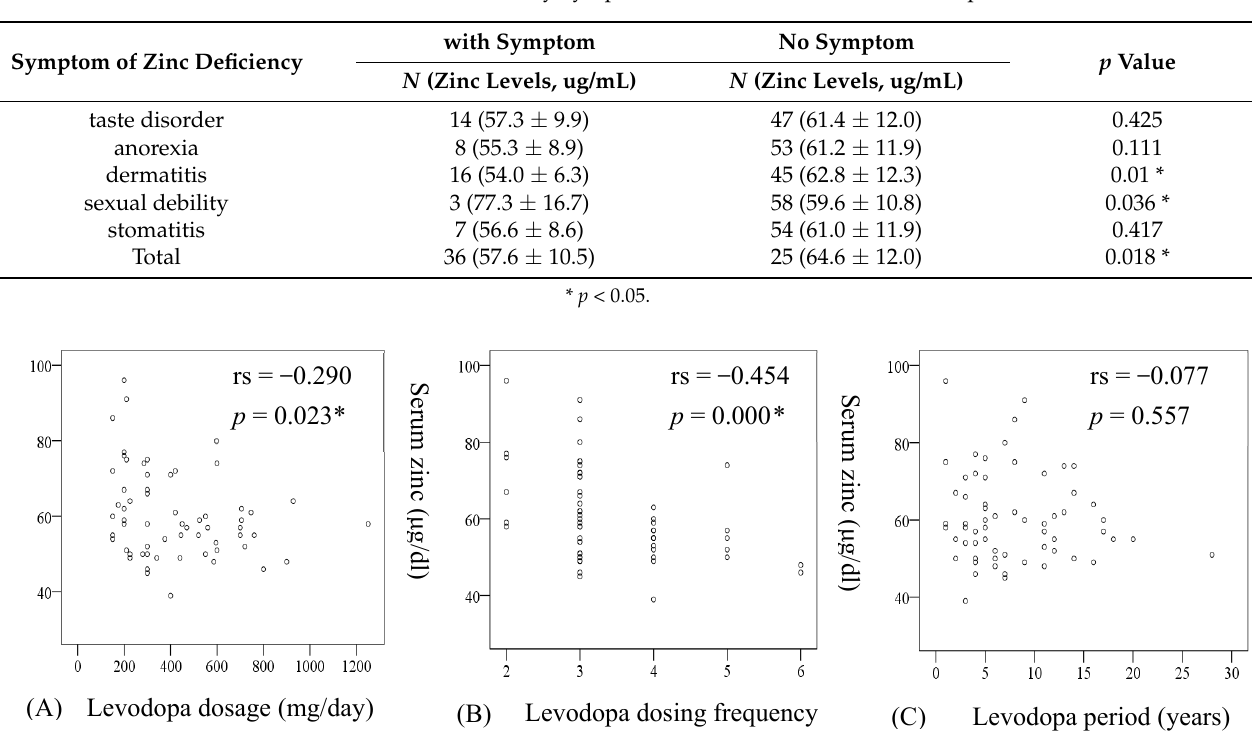
Figure 1. Correlation between patient background and serum zinc level. A significant negative relationship with serum zinc levels was found in levodopa dosage ( A : rs = − 0.290, p = 0.023) and dosing frequency ( B : rs = 0.454, p = 0.000), but none was found in the levodopa period ( C : rs = − 0.077, p = 0.557). * p <